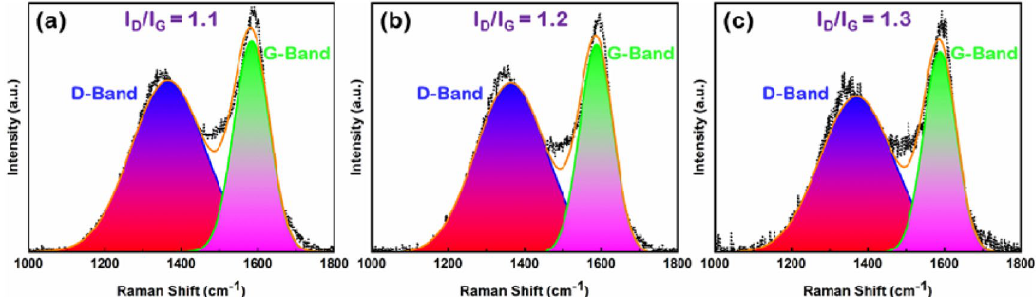
Figure 6. Raman spectra of CNS prepared at 650 °C from nettle leaves ( a , c ) and ( b ) stems using NaHCO 3 as activating agent. The ratio of nettle powder and NaHCO 3 is 1:1 ( a , b ) and 1:2 ( c